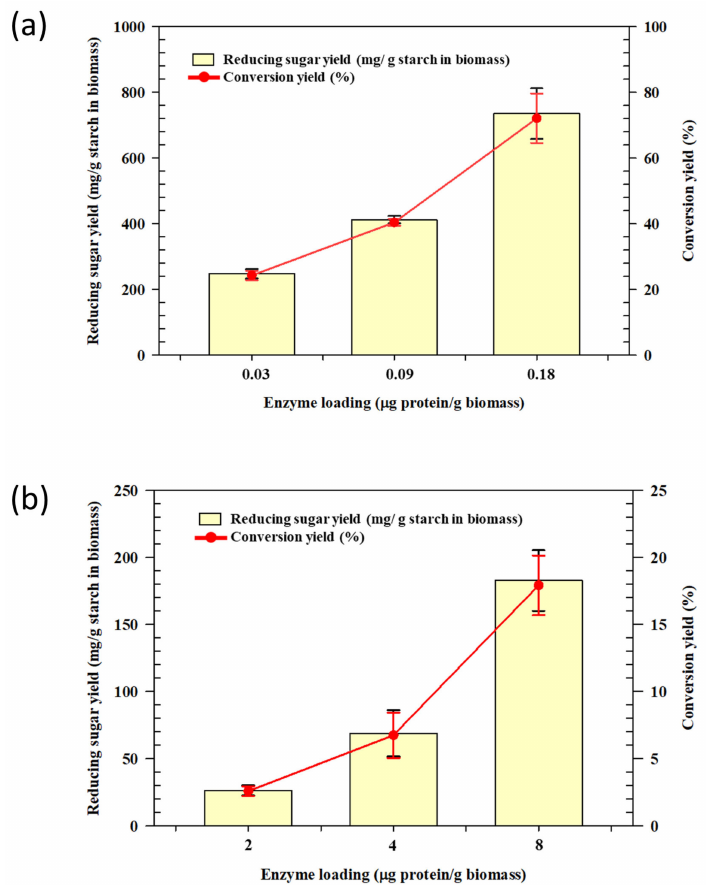
Figure 7. The effect of HL11Amy dosage on reducing sugar yield from cassava pulp hydrolysis. ( a ) Gelatinized cassava pulp hydrolysis efficiency determined based on starch content in biomass and total biomass; ( b ) raw cassava pulp hydrolysis efficiency determined based on starch content in biomass and total biomass. The reaction contained 1% ( w / v ) cassava pulp in 50 mM sodium citrate buffer pH 4.0 with the varying enzyme dosage and incubated at 50 ◦ C for 24